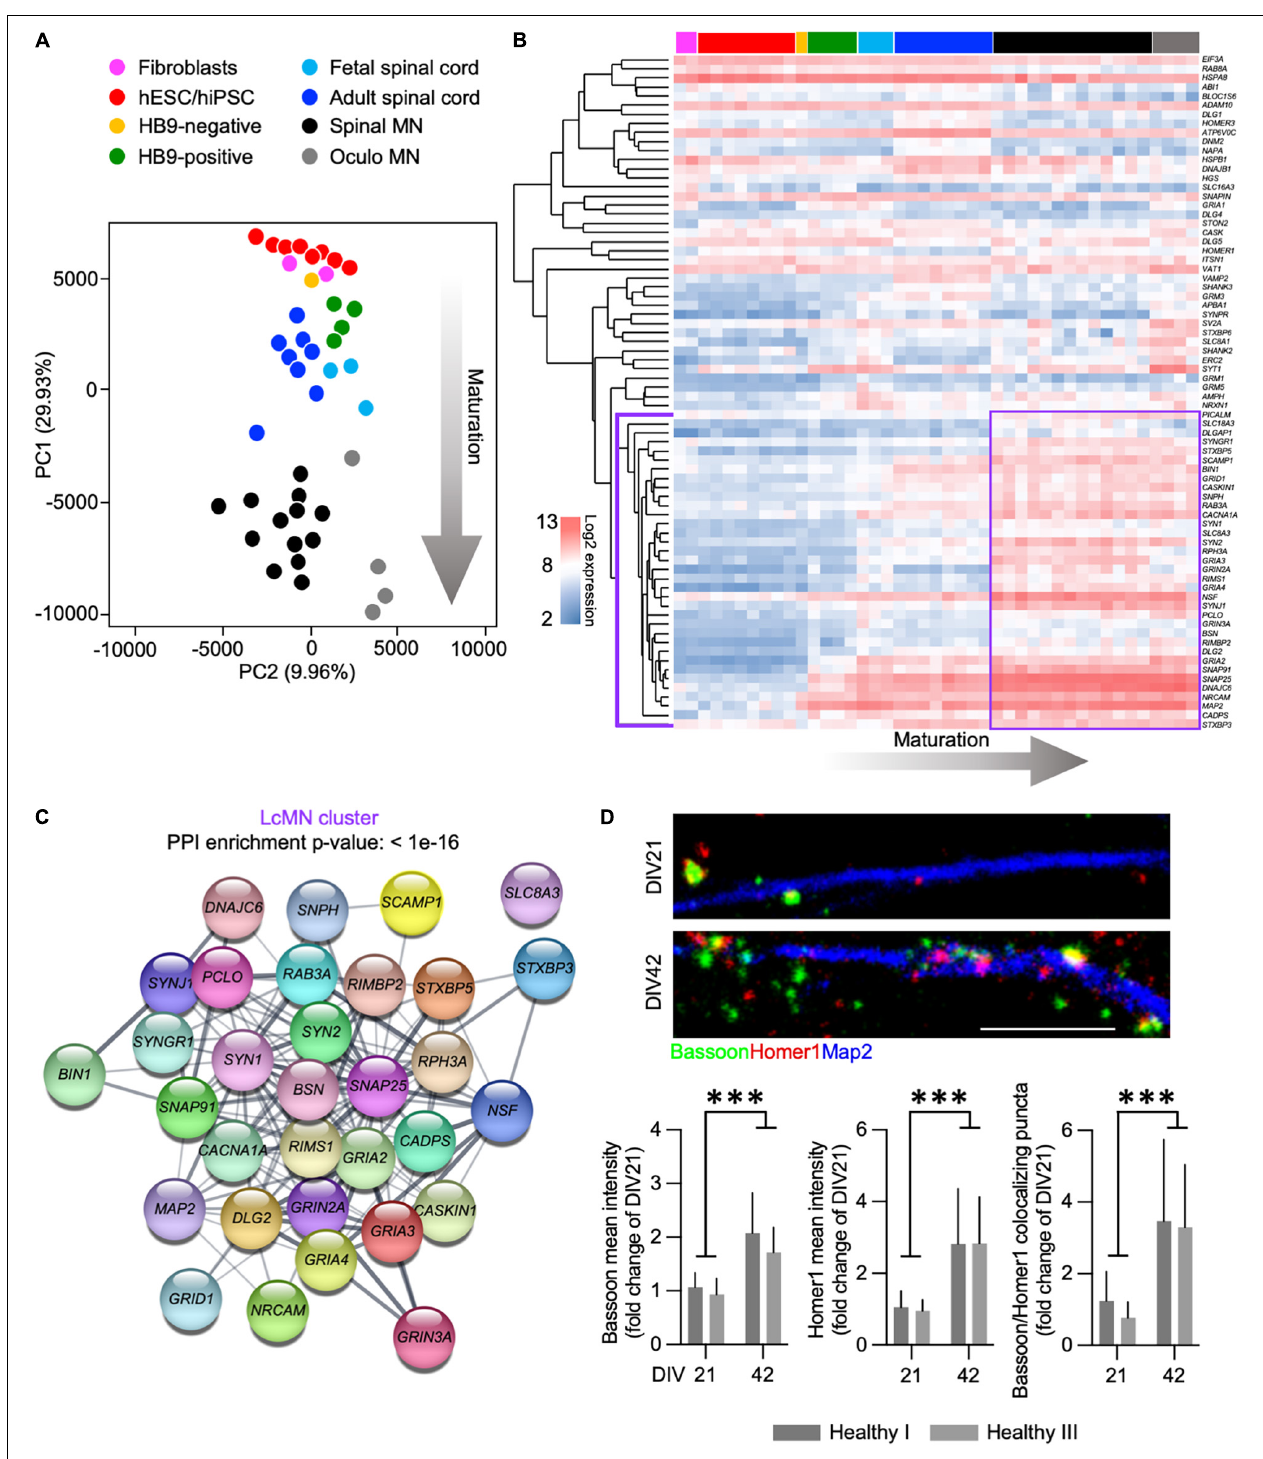
FIGURE 1 | Expression of synaptic transcripts shapes differentiation and maturation of human motor neurons. (A) PCA based on the synaptic transcriptome showing the dynamics of maturation (arrow) from undifferentiated stem cells to laser-captured adult MN along PC1. (B) Unsupervised hierarchical clustering of 74 synaptic genes highlighting the LcMN cluster of transcripts (outlined in violet) whose higher expression defines adult motor neurons. (C) Protein-protein interaction analysis performed with STRING identifies a significant ( p < 10 − 16 ) functional networking between the genes of the LcMN cluster. (D) Confocal images and analysis of the synaptic markers Bassoon, Homer1 and their colocalization in DIV21 and DIV42 MN from healthy individuals showing a significant increase in the density of synaptic contacts upon maturation. Scale bar: 5 µ m. ∗∗∗ p < 0.001.